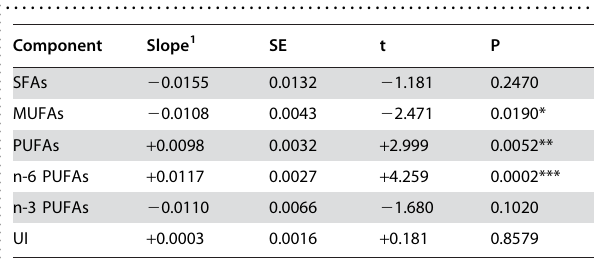
Table 1. Regression results for the relation between